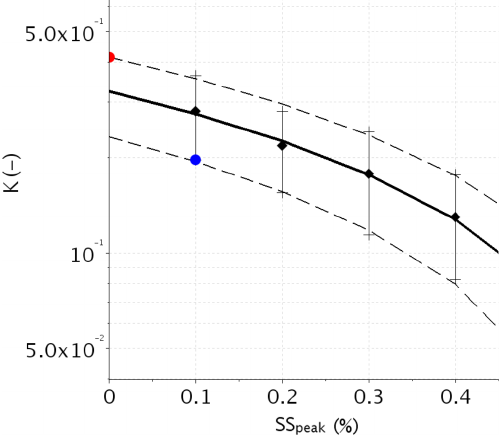
Figure A3. Derived κ values as a function of CCN chamber supersaturations from measurements over the 1h time period before the fog event for the f6 case. Mean (diamond, solid line) and mean ± 1 standard deviation (dashed lines). Extrapolated κ inf (blue dot) and κ sup (red dot) are also